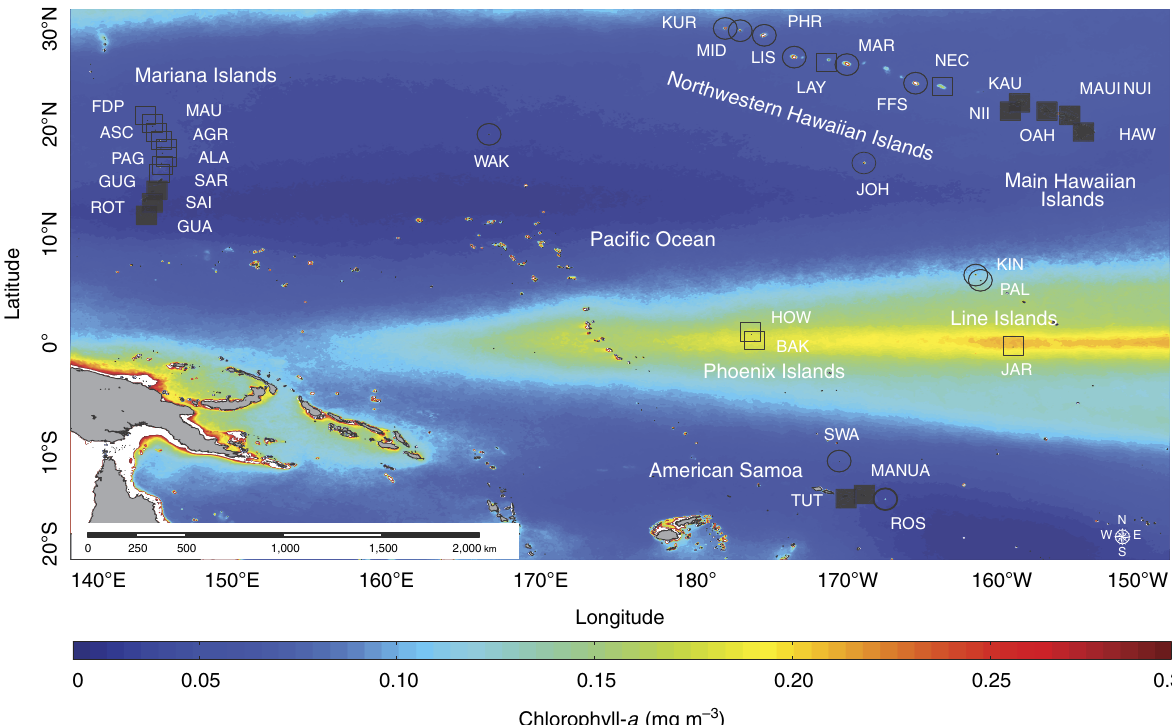
Figure 2 | Map of the Pacific highlighting the coral reef islands and atolls used in this study. Long-term mean (10 year) chlorophyll- a with coral reef islands (squares) and atolls (circles) that either have local human populations (filled) or are unpopulated (open). Please see Supplementary Table 1 for study location name